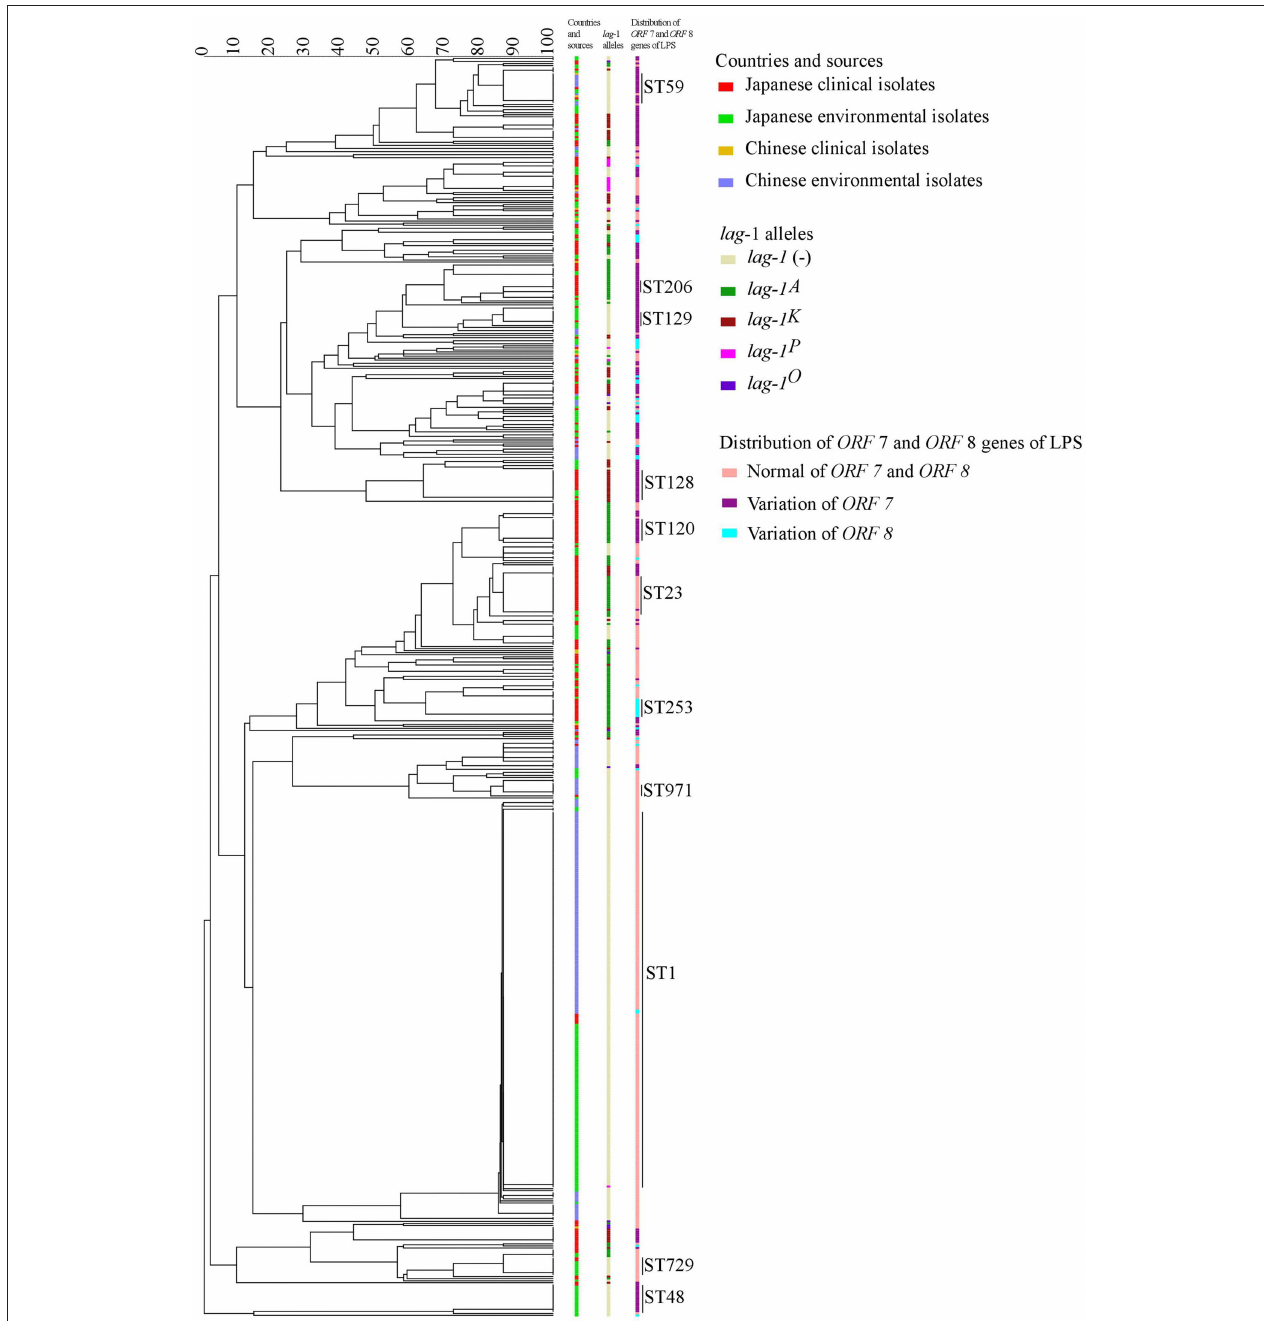
FIGURE 3 | Evolutionary tree based on seven targeting specific gene loci. In the tree, the groups by countries and sources, lag-1 alleles and distribution of ORF 7 and ORF 8 genes of LPS were showed in different